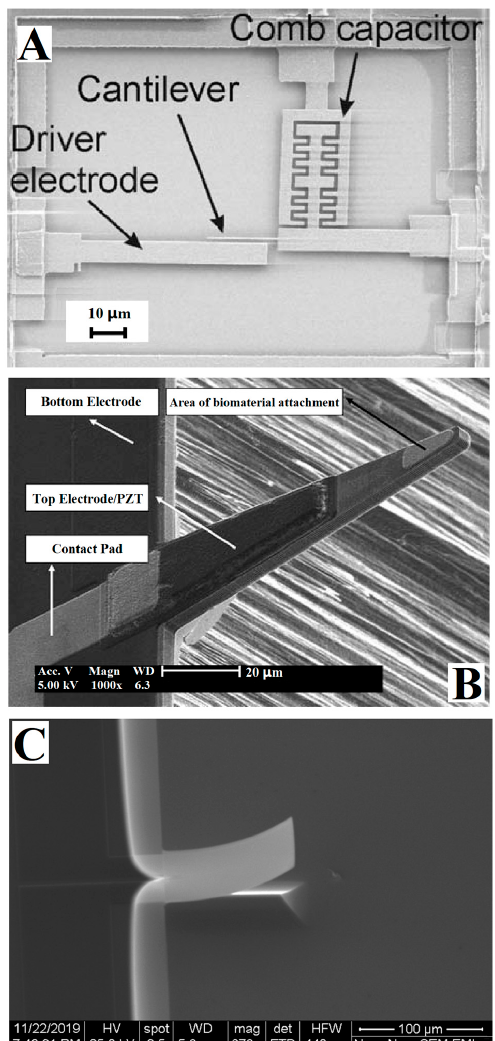
Figure 5. SEM images of microcantilever based on electrical measurement methods. ( A ) Microcan- tilever with comb capacitance detection, driver electrode, and CMOS signal amplification circuit proposed by Forsen et al. in 2005 [70]. ( B ) In 2007, Lee et al. achieved self-excited dynamic detection of the poly T-sequence DNA and a variety of proteins by using a PZT microcantilever [72]. ( C ) In 2021, Tian et al. developed a polyimide (PI)/Si/SiO 2 based piezoresistive microcantilever biosensor to achieve a trace level detection for aflatoxin B1 [75]. To enhance electrical measurement methods’ performance, many scholars have proposed improvement schemes. As shown in Figure 6A, in 2006, Shekhawate et al. [76] measured the nanometer-level deflection of a microcantilever by embedding a met-